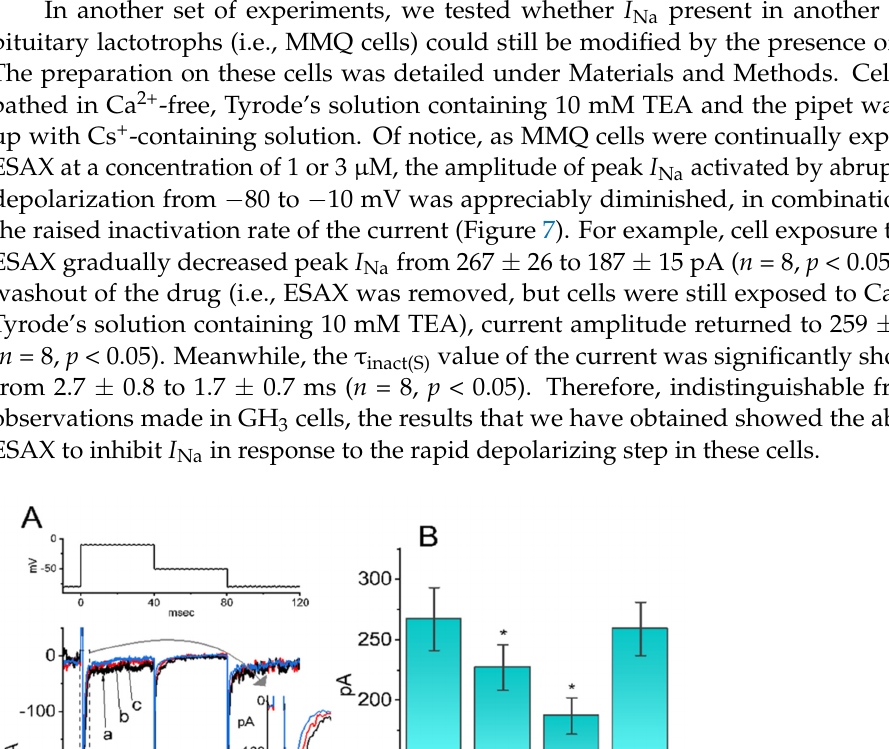
∞ ) loop (as demonstrated in the right side) of voltage-dependent hysteresis responding to the triangular ramp. ( C ) Figure-of-eight pattern in voltage-dependent hysteresis of I Na(P) activated by isosceles-triangular ramp voltage with a ramp duration of 3.2 s (or a ramp speed of ± 0.094 mV/ms) in the presence of 10 µ M Tef. The ascending limb is indicated in blue color, while the descending one is in the orange color. The dashed arrow indicates the direction of current trajectory by which time goes. ( D ) Summary bar graph showing the effects of Tef (10 µ M) and Tef (10 µ M) plus ESAX (10 µ M) on I Na(P) amplitude activated by the upsloping and downsloping limb of 0.8-s triangular ramp pulse (mean ± SEM; n = 7 for each bar). Current amplitude in the left side was taken at the